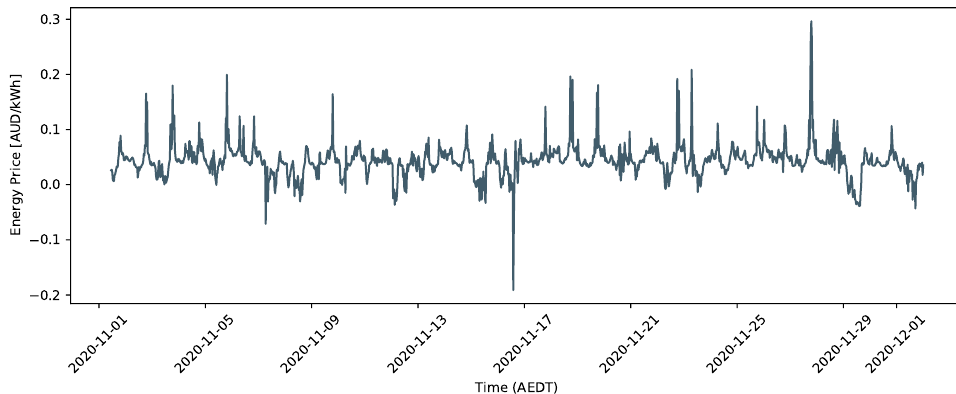
Figure 2. Half-hourly energy prices during the planning horizon. The plot shows that there are times with a negative energy price. A peak load charge of β = AUD 0.005 per kW 2 of the squared monthly peak load is assumed. Office hours are considered to be from 9:00 to 17:00 of each working